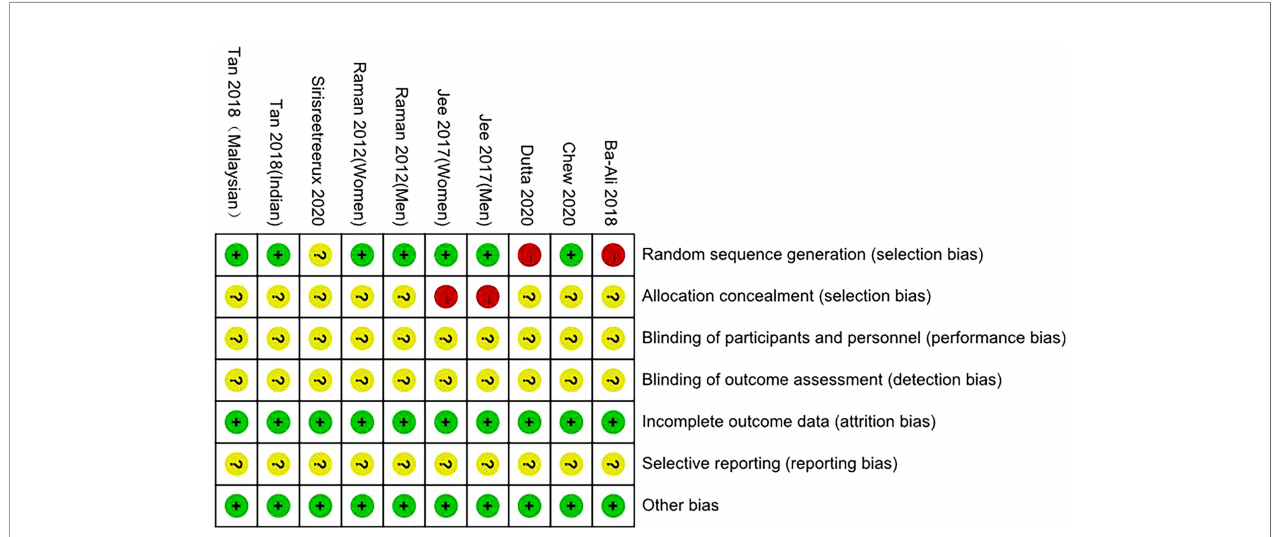
FIGURE 2 | Overview of bias risk assessment of included literature.